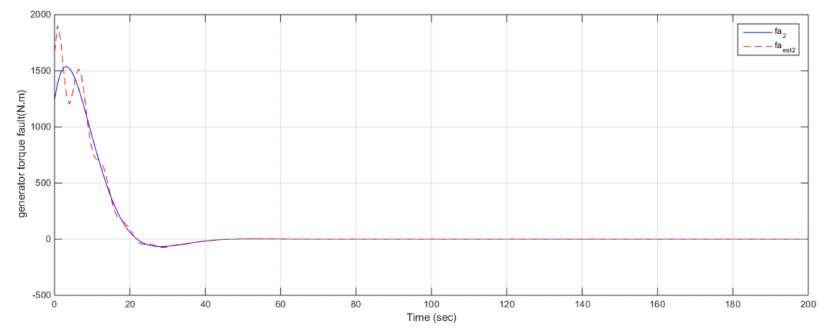
Figure 12. Generator fault and its estimation.